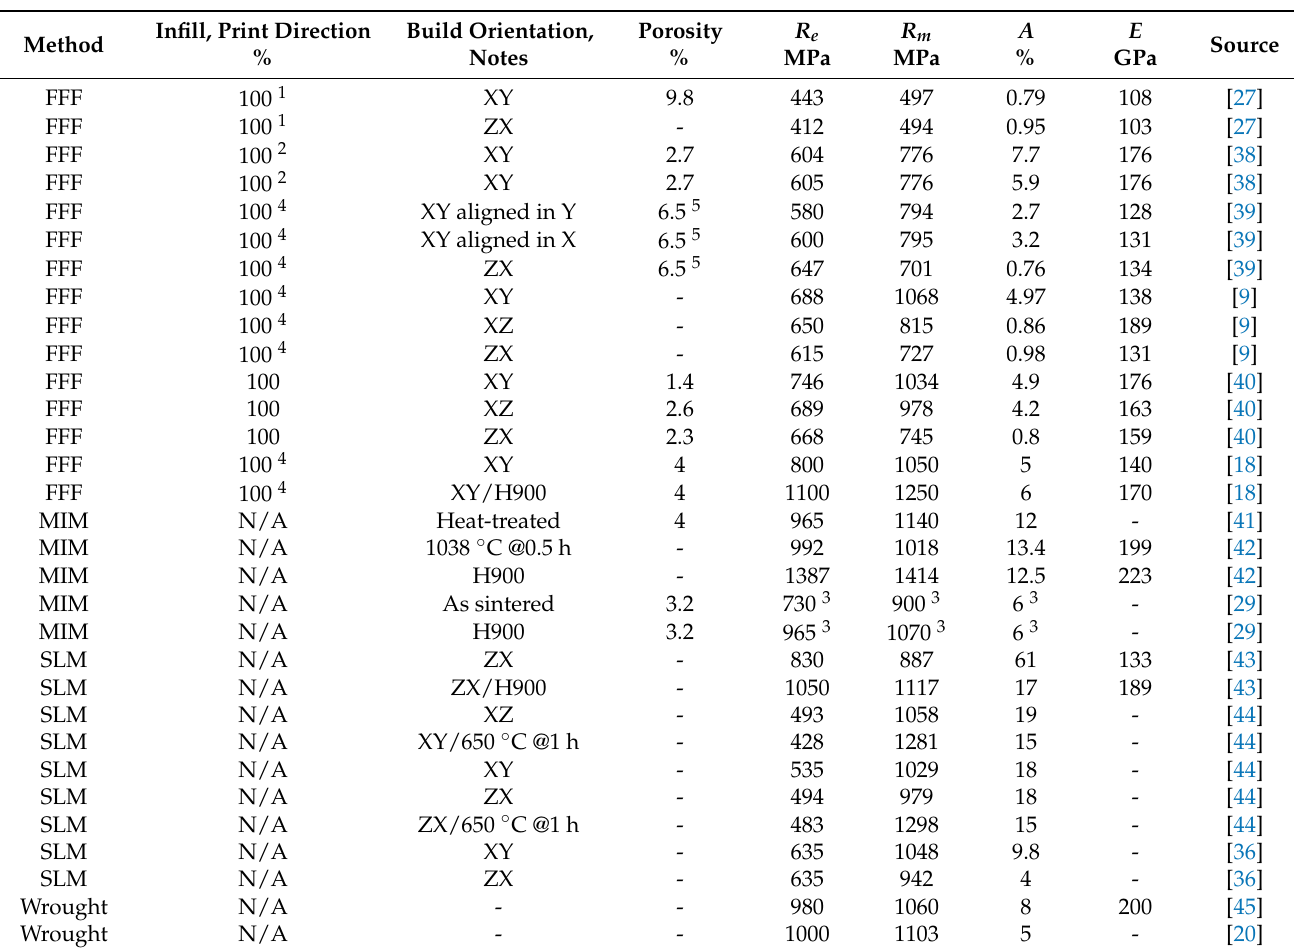
Table 11. Overview of tensile properties for 17-4 PH stainless steel produced using metal FFF, SLM and